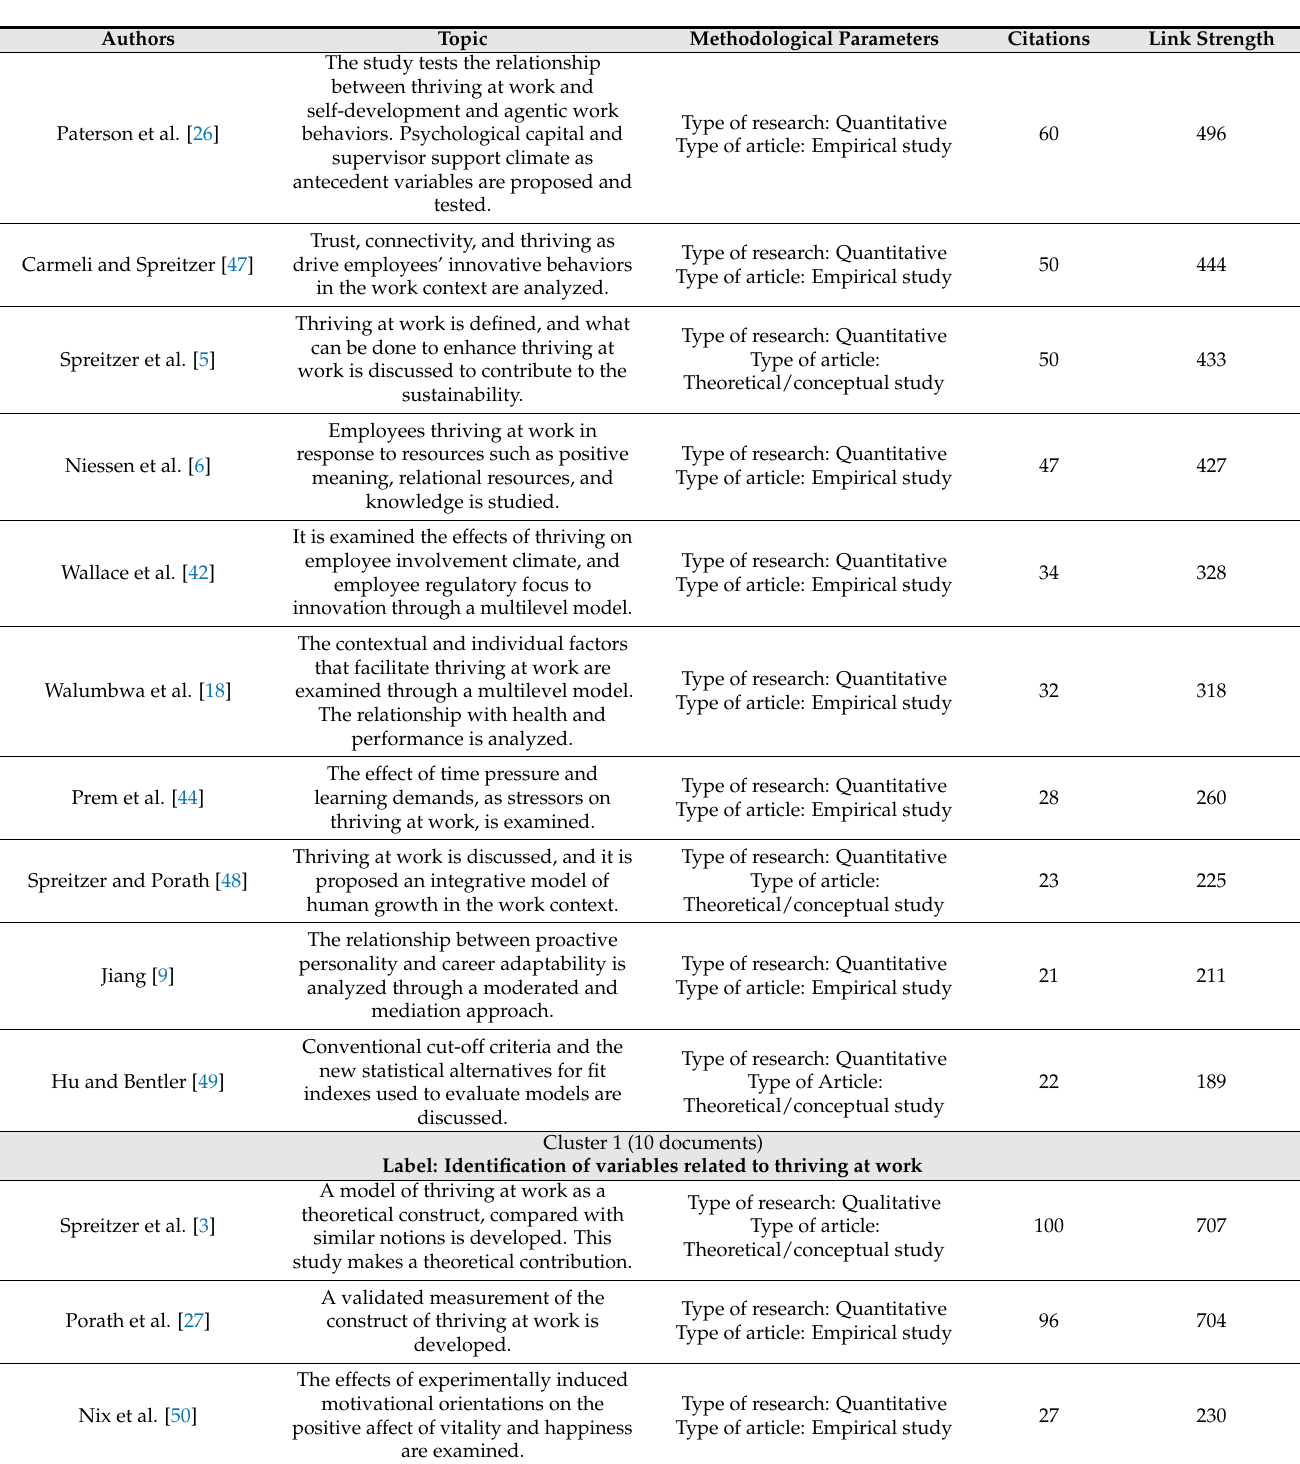
Table 13. Content analysis of the three clusters was obtained through the co-citation analysis